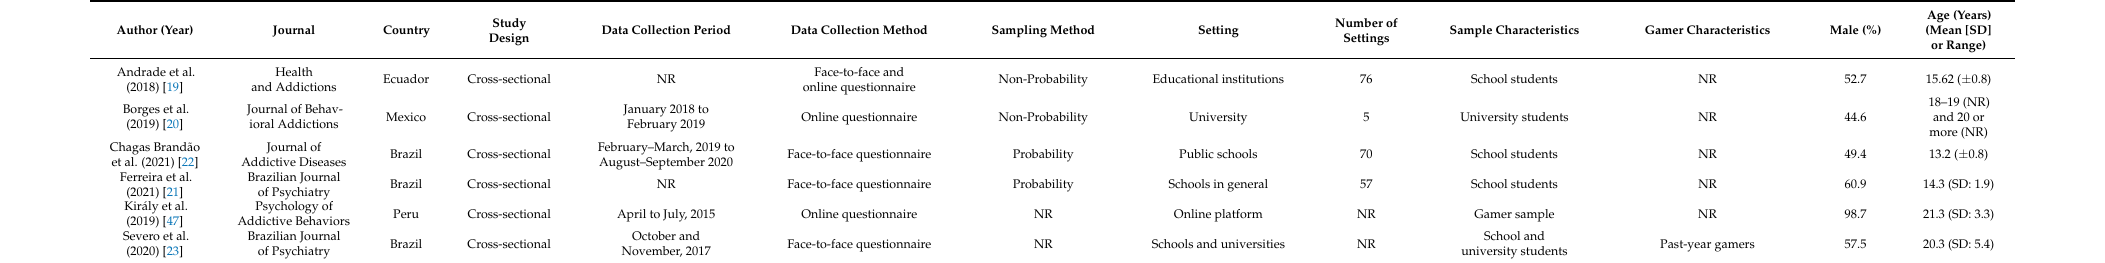
Table 1. Characteristics of the studies included.